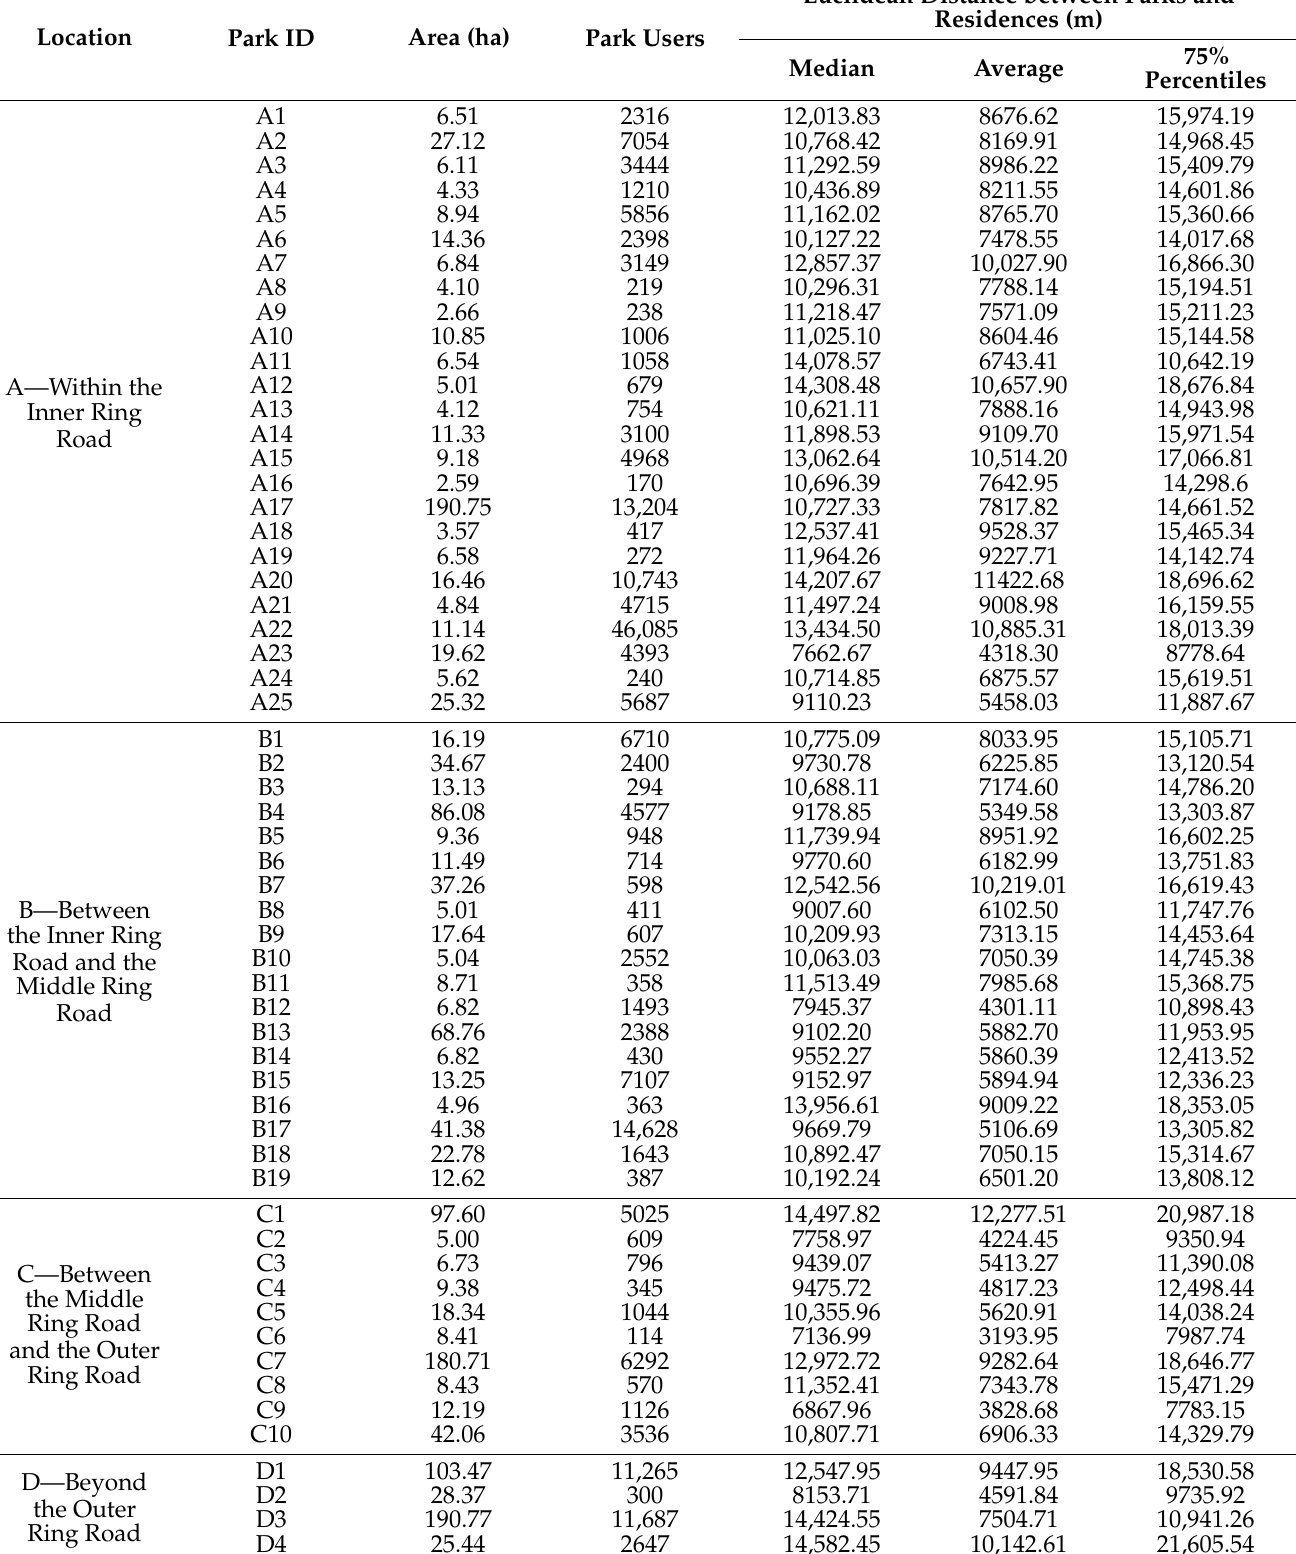
Table 2. Descriptive statistics of Euclidean distance (m) between parks and visitors’